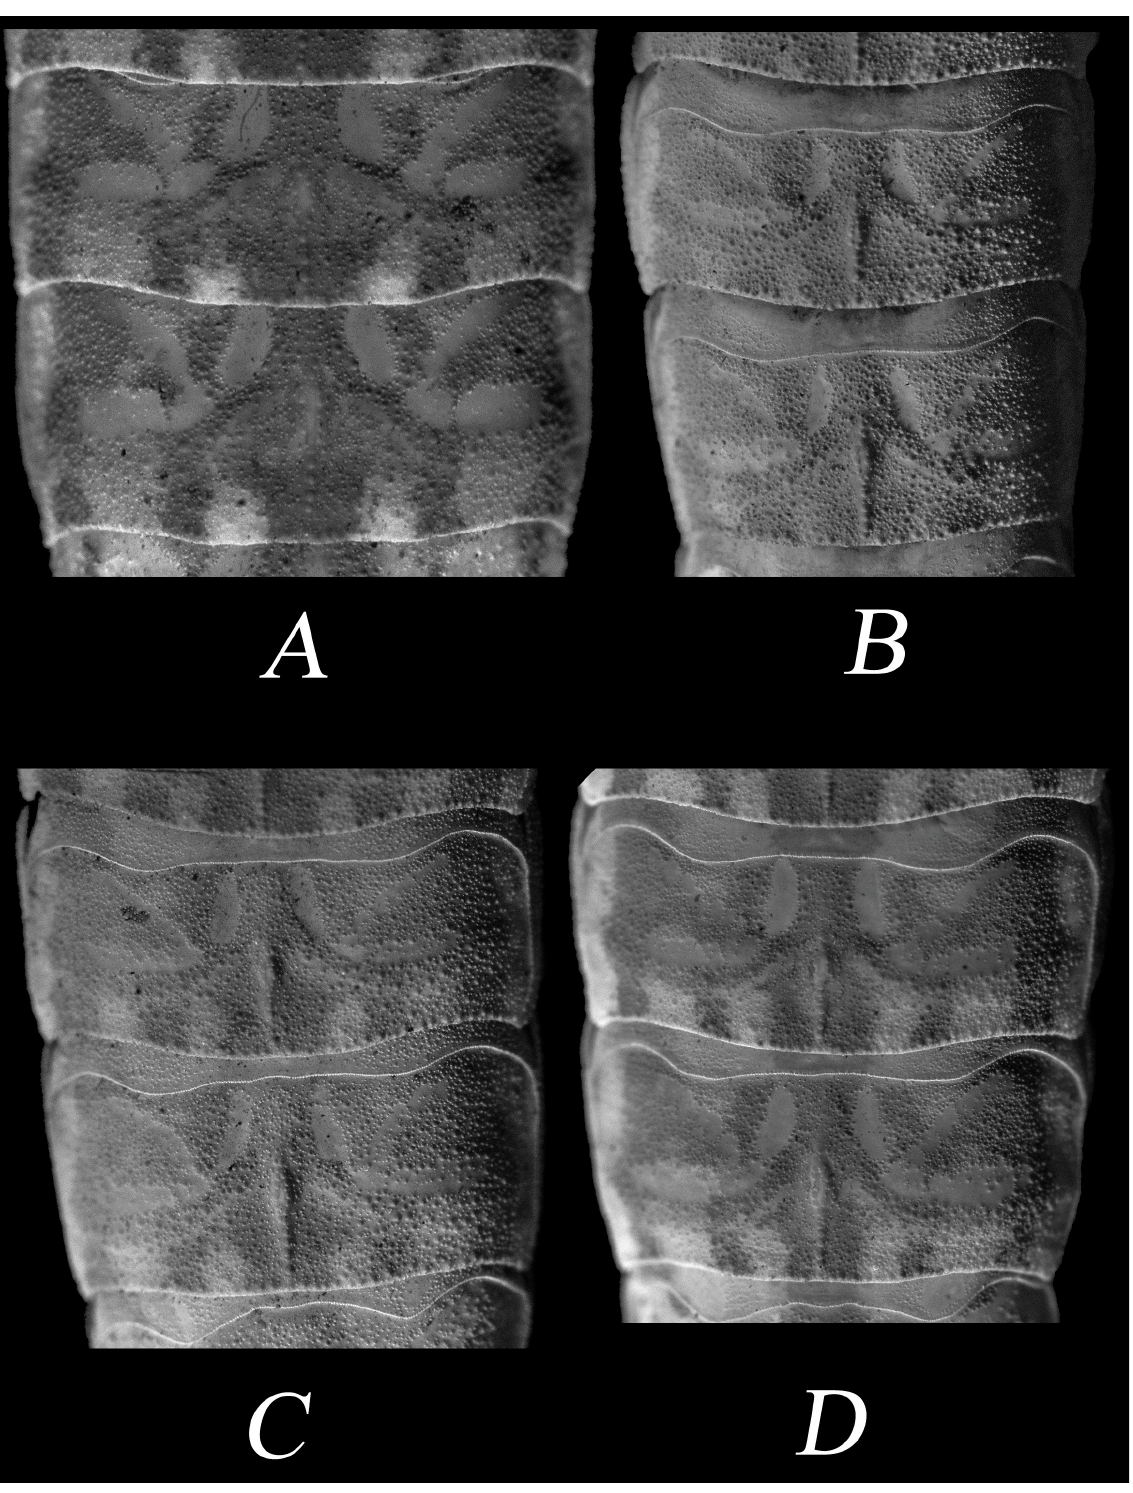
Fig. 20. Mesosomal tergites V and VI in dorsal view under UV light. A . Isometrus thurstoni Pocock, 1983, topotype, adult ♂ (INHER-139). B . I. tamhini Sulakhe et al ., 2020, holotype, adult ♂ (BNHS SC 155). C . I. amboli Sulakhe et al ., 2020, holotype, adult ♂ (BNHS SC 157). D . I. kovariki Sulakhe et al ., 2020, holotype, adult ♂ (BNHS SC